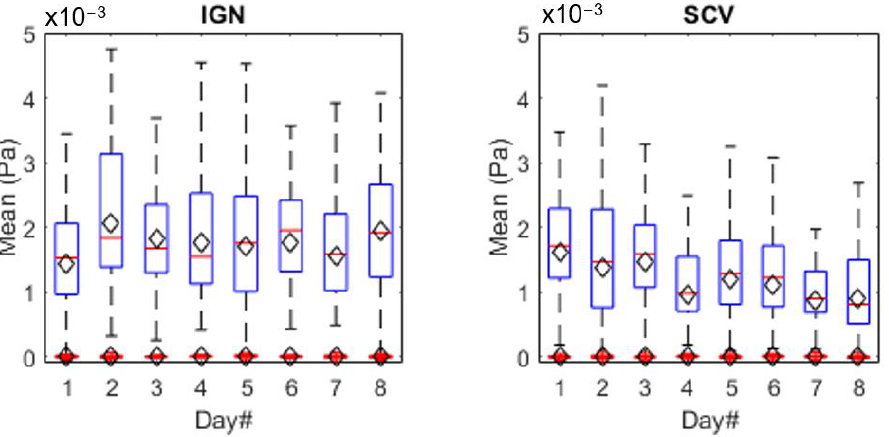
Figure 15. Mean values computed for spark and noise data at sensor locations IGN and SCV.